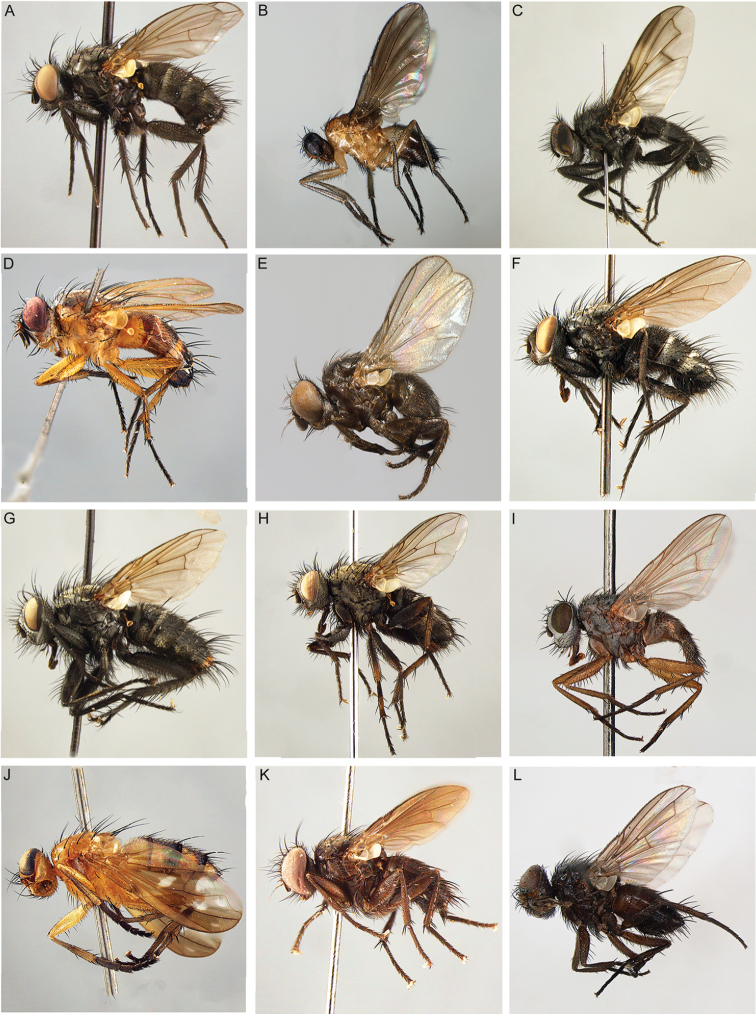
Rhinophoridae, habitus in lateral view. AOplisa
tergestina ♂ (Italy) BParazimimus
congolensis ♂ (Burundi) CPaykullia
partenopea ♂ (Italy) DQueximyia
flavipes ♂ (South Africa) ERhinodonia
antiqua ♂ (New Caledonia) [holotype] FRhinomorinia
sarcophagina ♂ (Italy) GStevenia
palermitana ♂ (Italy) [holotype] HTricogena
rubricosa ♂ (Morocco) ITromodesia
angustifrons ♀ (Israel) [paratype] JTrypetidomima
lutea ♀ (Brazil) KVentrops
incisus ♂ (Tanzania) [paratype] LVentrops
stuckenbergi ♂ (Namibia) [holotype].